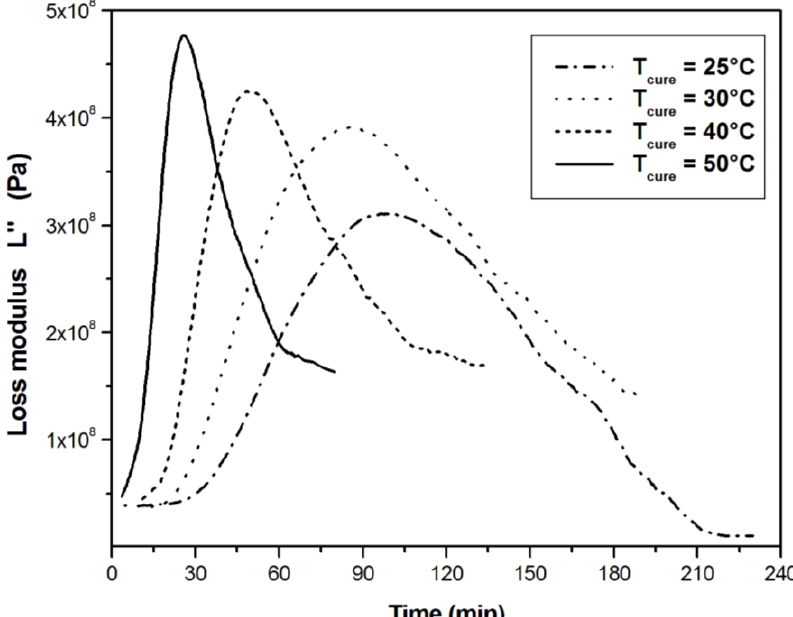
Figure 4. Loss modulus L ″ measured at 2 MHz during the isothermal cure of unsaturated polyester resin at different cure